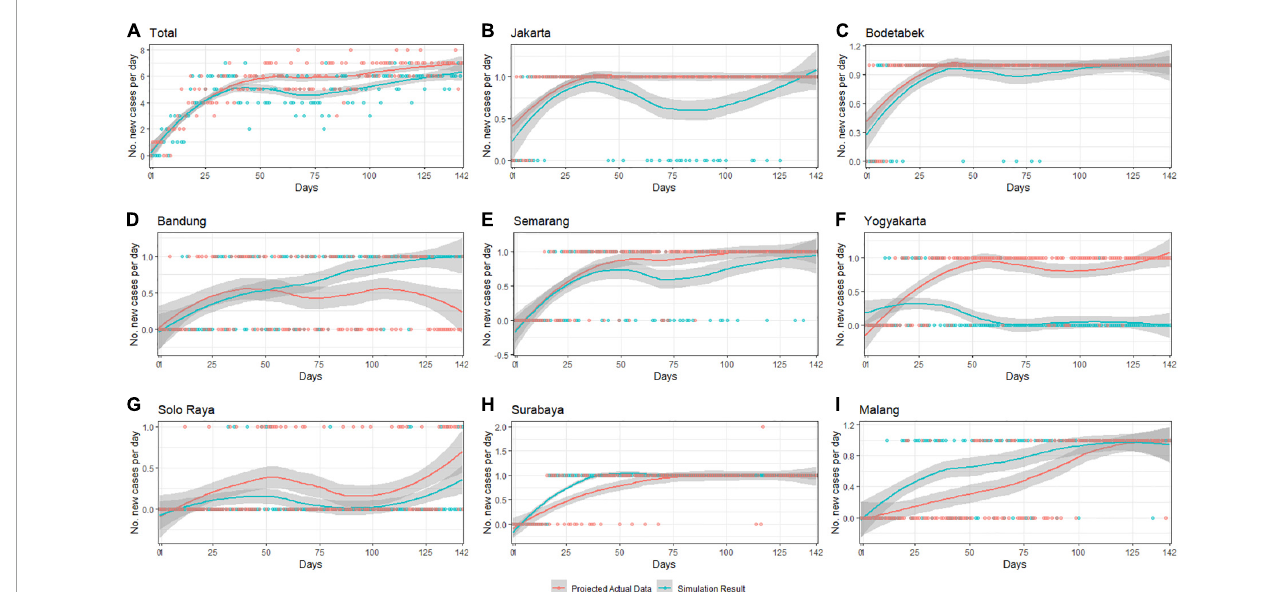
FIGURE7 Dynamics of the proportion of detected daily cases per population from observed data (red line) and simulated data (blue line) in (A) all cities and each city [ (B) Jakarta, (C) Bodetabek, (D) Bandung, (E) Semarang, (F) Yogyakarta, (G) Solo Raya/Surakarta, (H) Surabaya, and (I)